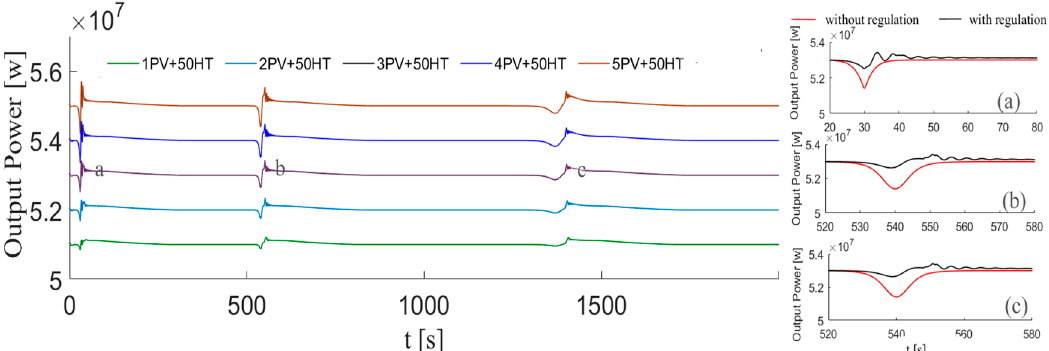
Figure 13. Output power of a PV-HT hybrid system with 50% solar radiation fluctuation, for fluctuation times of 1, 2, 10 min; ( a – c ) are the comparisons of output power with and without hydro turbine regulation of a 3 MW photovoltaic system.